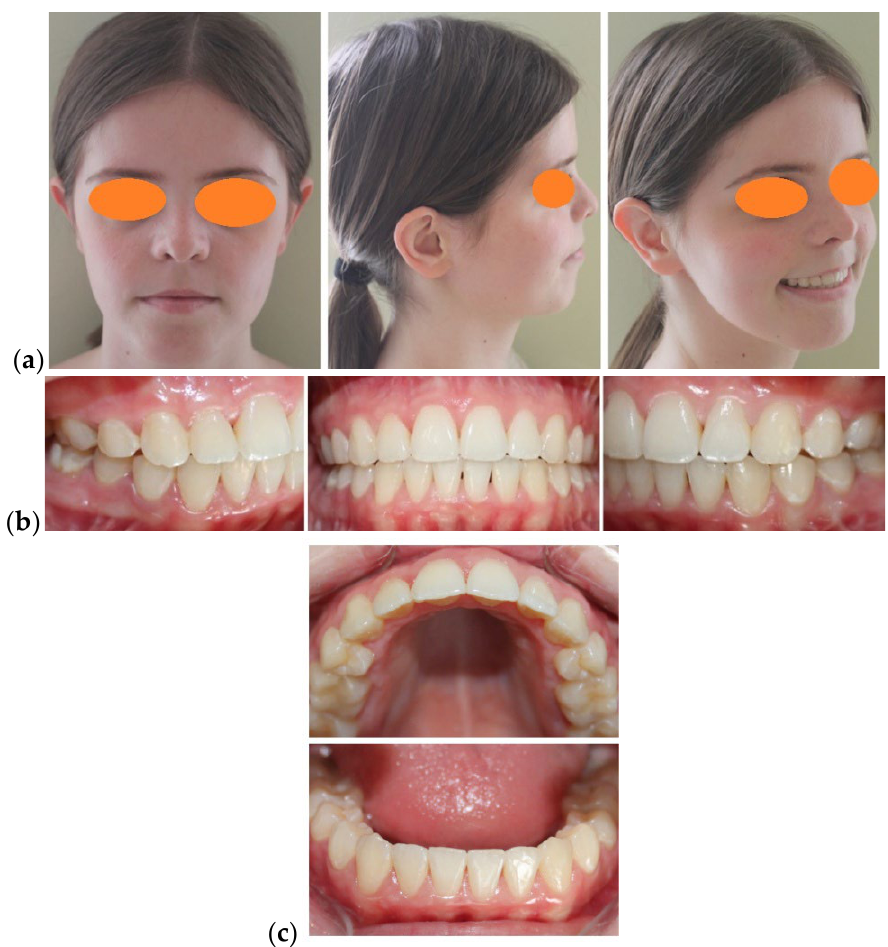
Figure 8. After 24 months from debonding photographic examination: ( a ) Facial aspect: frontal view, profile, ¾ profile on smiling; ( b ) Intra-oral aspect: lateral right, frontal and lateral left; ( c ) Intra-oral aspect: occlusal view.